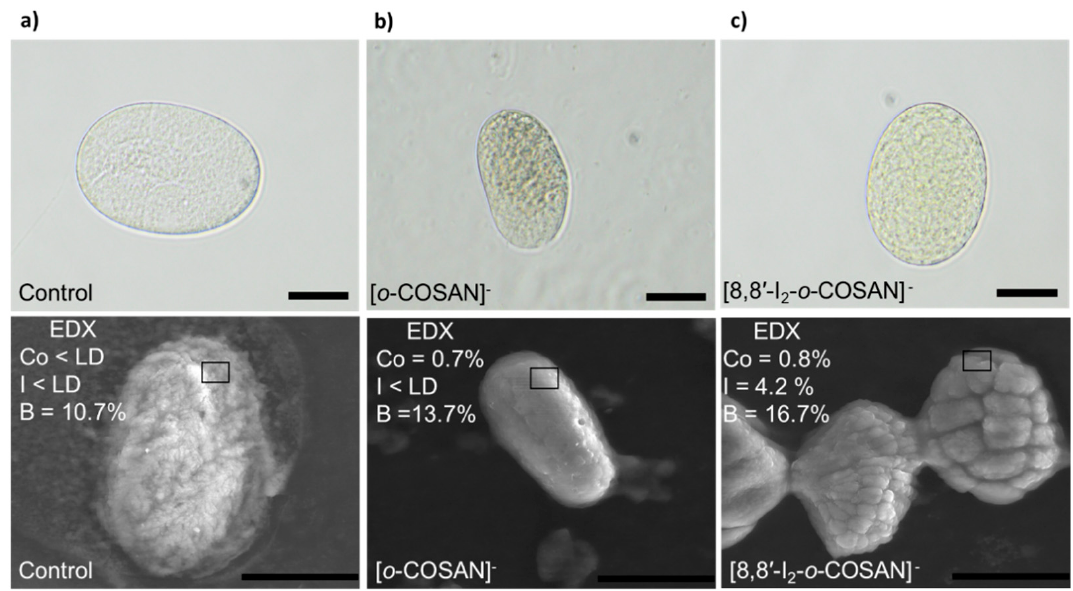
Figure 9. Optical and SEM images of the C. elegans embryos. ( a ) eggs-control; ( b ) after treatment with 200 µ M of Na[ o- COSAN] for 24 h at room temperature under gentle agitation; ( c ) after treatment with 200 µ M of Na[8,8 (cid:48) -I 2 - o- COSAN] for 24 h at room temperature under gentle agitation. Bar size 20 µ m.